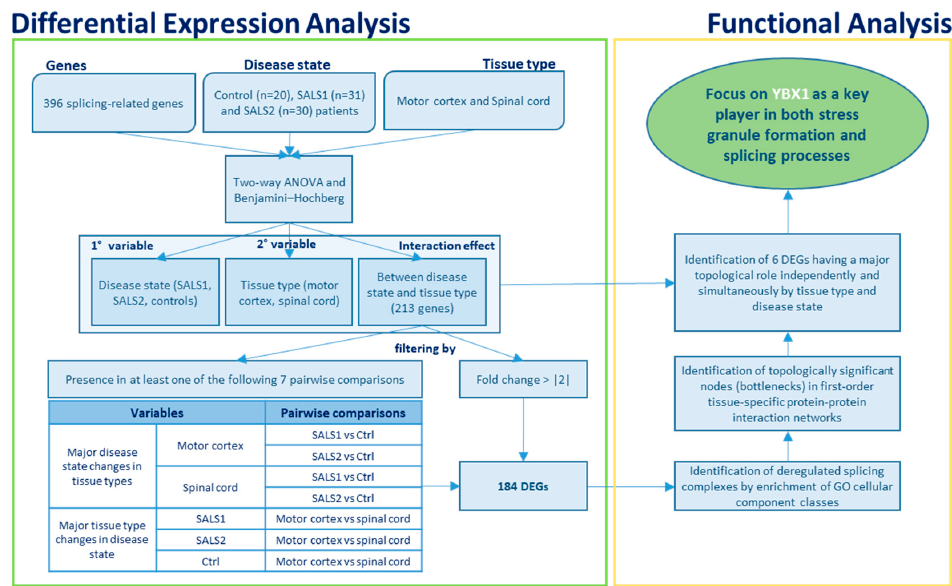
Figure 1. The flow chart illustrates the analysis methods used in the present study to characterize the differentially expressed genes encoding splicing factors (left green box) and investigate their functional significance (right orange box).